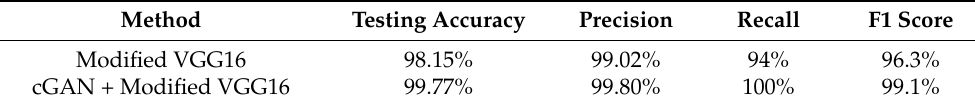
Table 4. Overview of our obtained final